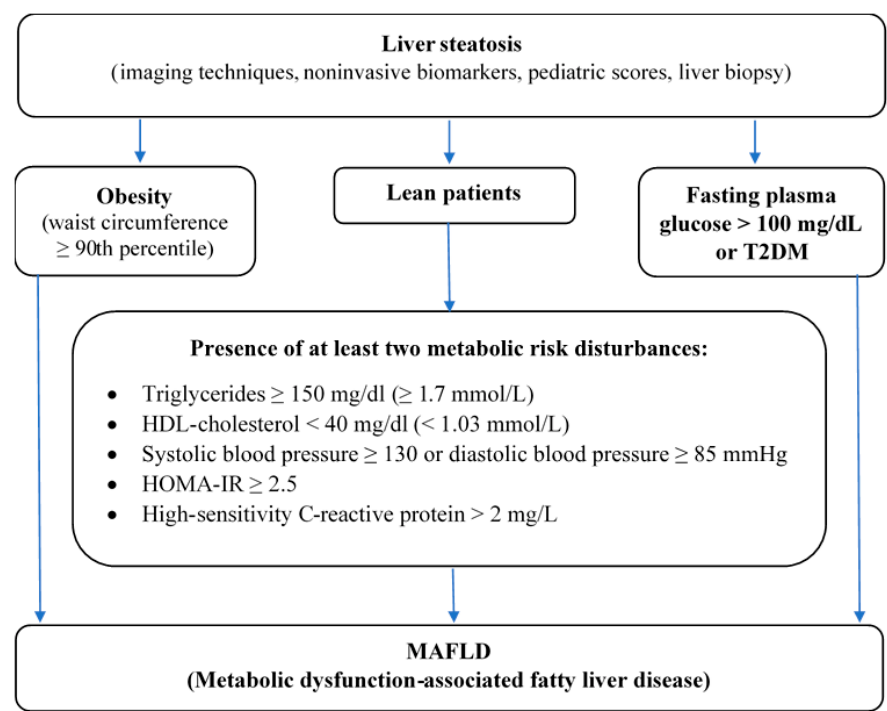
Figure 2. A proposed diagnostic criteria for MAFLD in patients aged 10–16 years old (adopted from Eslam et al. and IDF (International Diabetes Federation) definition of MetS in children and adolescents).